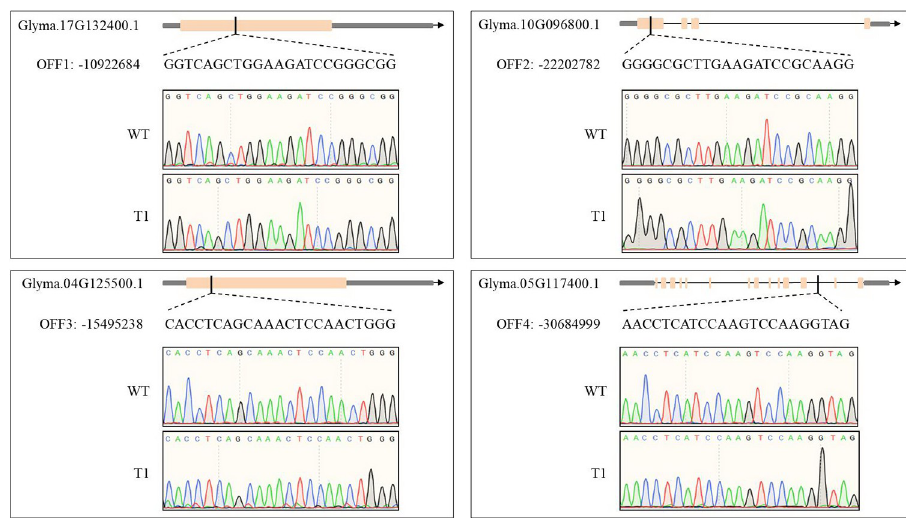
Fig 3. Potential off-target analysis at the two target sites of GmTCP19L in the T1 generation. WT, wild-type soybean plant. T1, the homozygous of tcp19l mutants in the T1 generation.